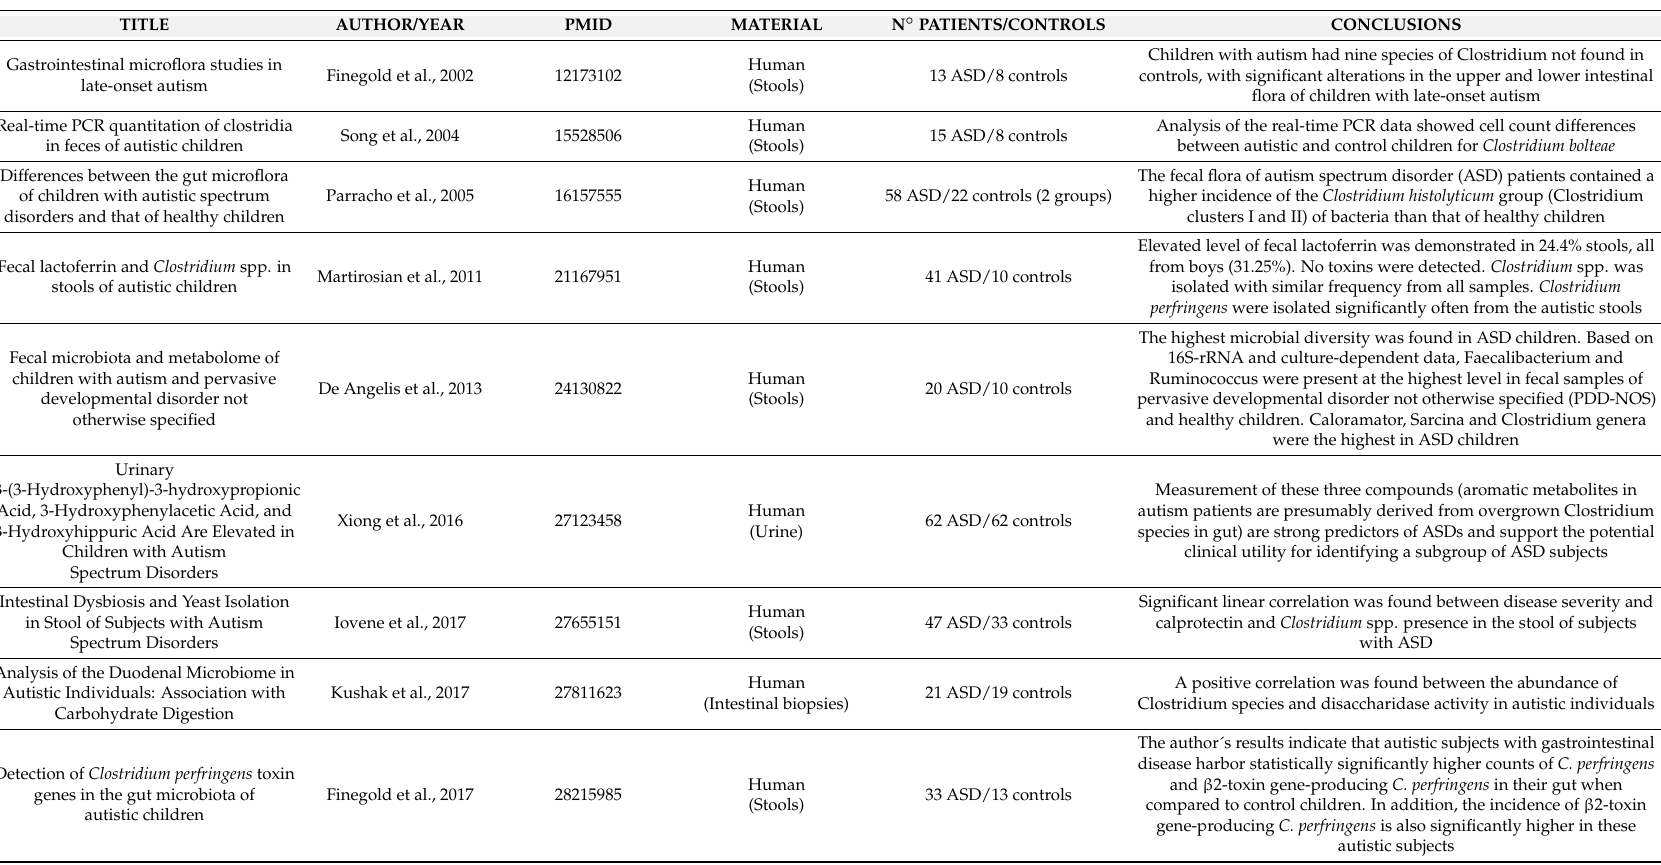
Table 1. Evidence for the link between Clostridium bacteria and autism spectrum conditions. Table summarizing the main results of nine studies included in the systematic review. The table is organized by year of